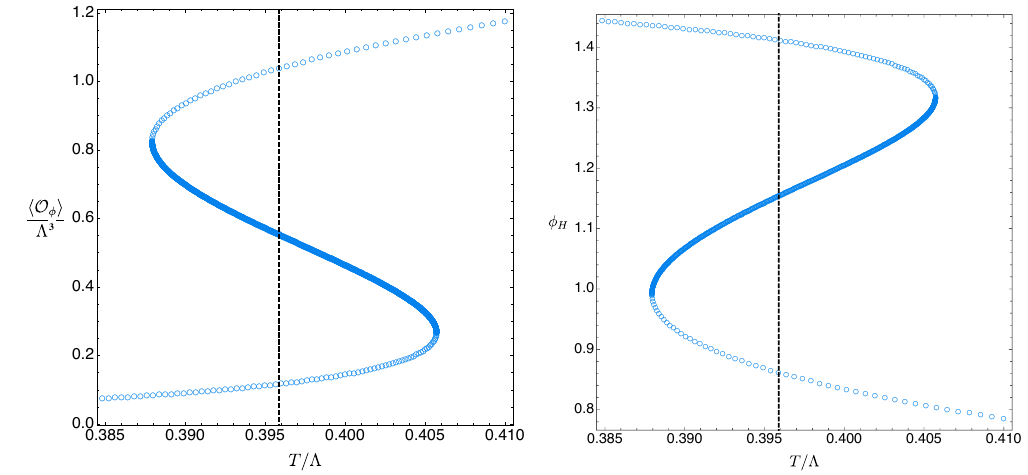
Figure 4 . (Left) Dimensionless expectation value hO φ i / Λ 3 of the operator with source Λ as a function of the dimensionless temperature ˆ T of the uniform branes. (Right) Value of the scalar field of the uniform branes at the horizon φ H as a function of ˆ T